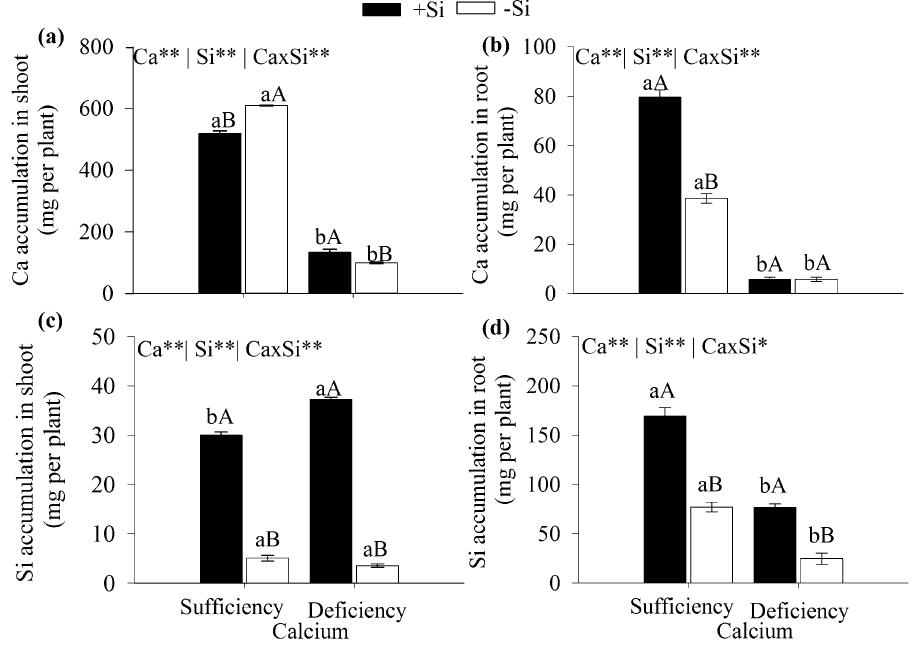
Figure 2. Ca accumulation in the aerial part ( a ) and root ( b ), Si accumulation in the aerial part ( c ) and the root ( d ) of cabbage grown under Ca sufficiency and deficiency, with (− Si) and without Si (+ Si). F test was applied: *( p ≤ 0.05) and **( p ≤ 0.01). The student t means comparison test was applied. Lowercase letters ( a , b ) indicate significant differences to calcium within the same level as Si ( p < 0.05). Uppercase letters ( A , B ) indicate significant differences for silicon within the same level as Ca ( p < 0.05). The bars represent the mean standard error. n = 5.